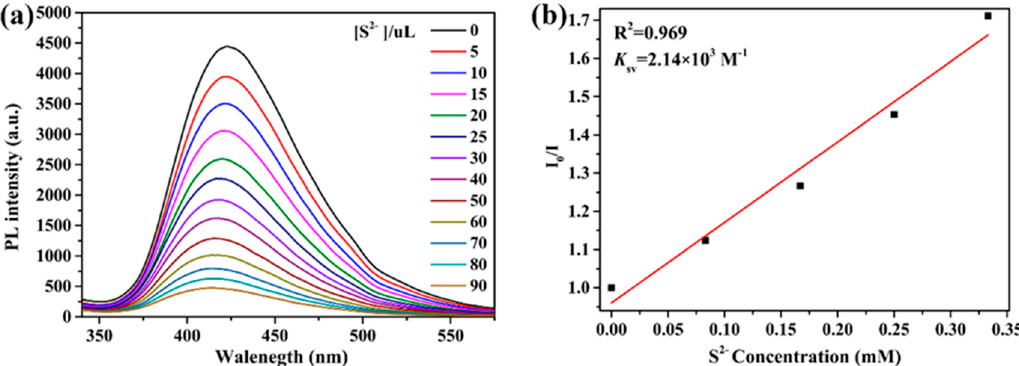
Figure 11. ( a ) Luminescence intensities of 2 in different concentrations of S 2 − ions. ( b ) Linear relation between S 2 − ions and I / I 0 − 1.